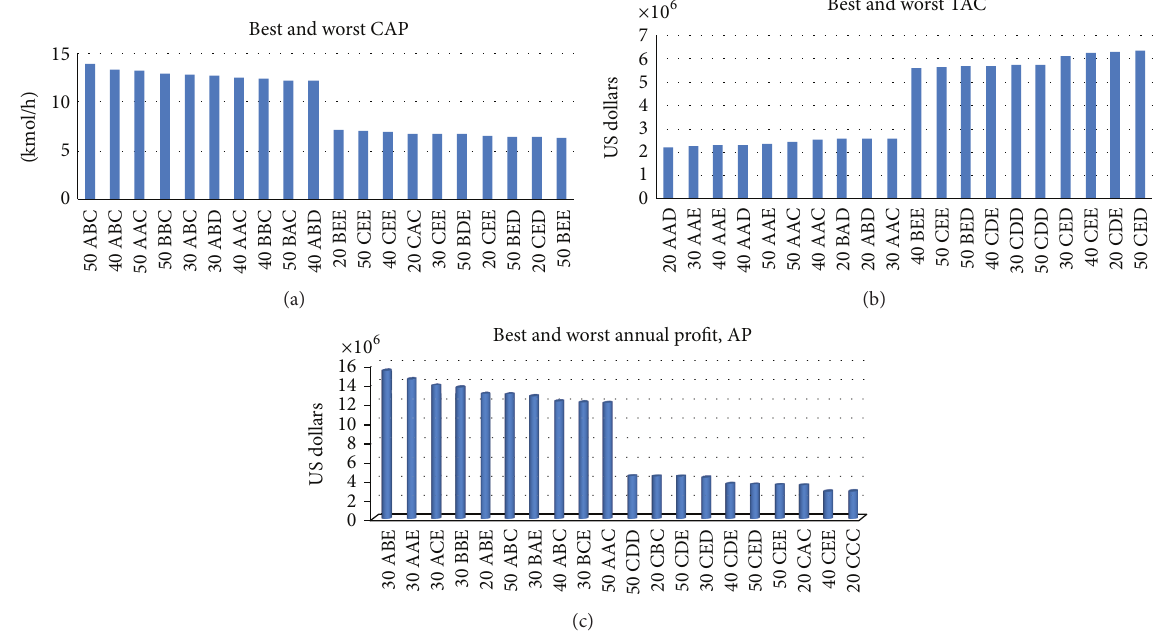
Figure 6: Best and worst cases for luyben capacity factor (CAP), total annual cost (TAC), and annual profit